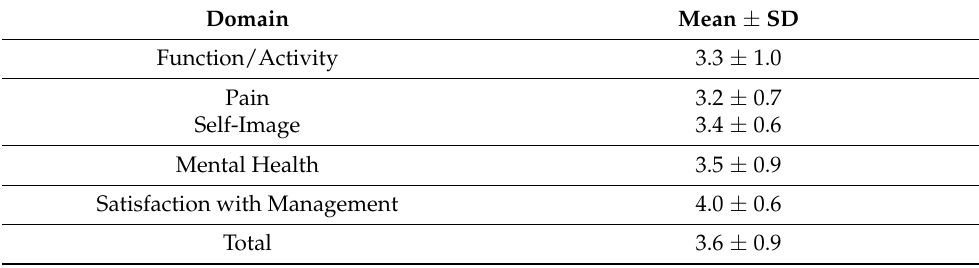
Table 2. Results of the German LD-SRS in total and its domains (SD = standard